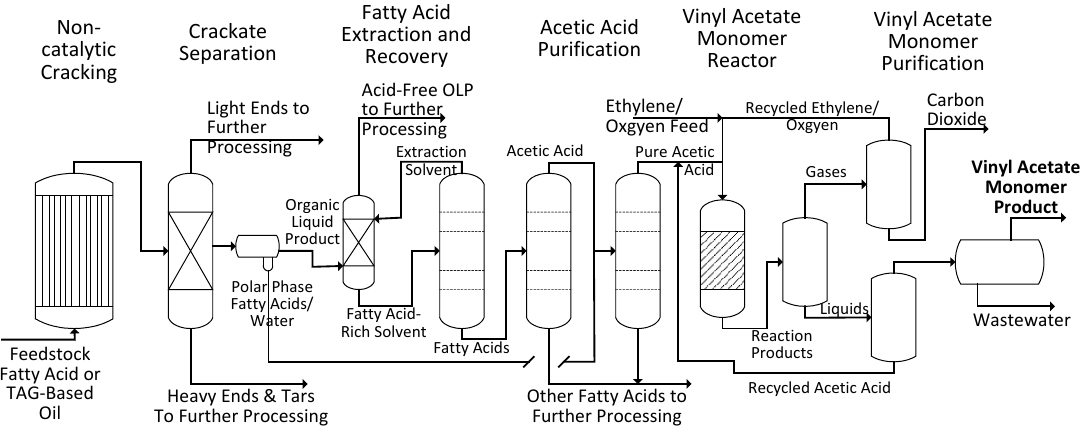
Figure 1. A simplified process scheme for the production of vinyl acetate monomer from a fatty acid or triacyl glyceride-based oil via non-catalytic